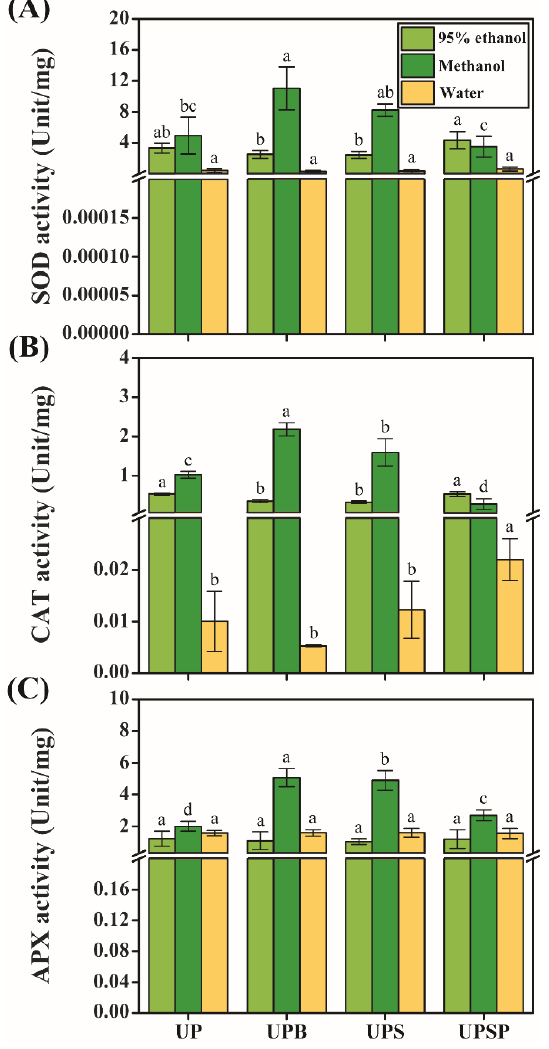
Figure 2. SOD, CAT, and APX activities of different parts of Undaria pinnatifida . ( A ) SOD, ( B ) CAT, and ( C ) APX activities. UP: whole U. pinnatifida, UPB: U. pinnatifida blade, UPS: U. pinnatifida stipe, UPSP: U. pinnatifida sporophylls. The different letters (a–d) indicate a significant difference ( p < 0.05).